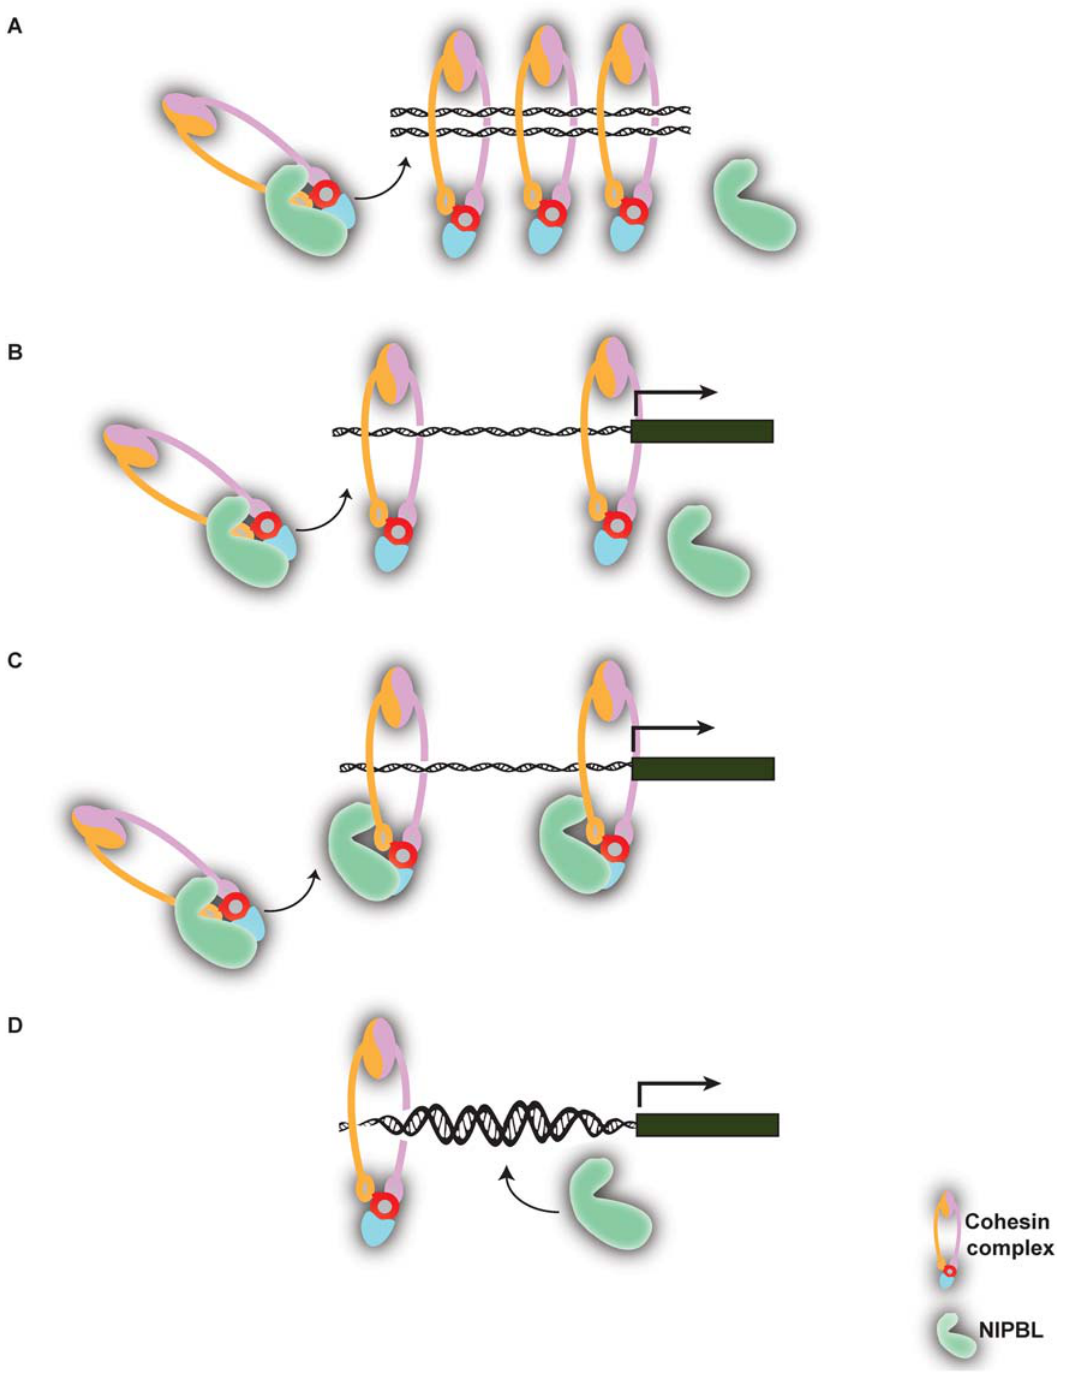
Figure 6. Proposed working models for cohesin and NIPBL. (A) Cohesin’s canonical role in regulating sister chromatid cohesion with NIPBL acting to facilitate the loading and unloading of the cohesin complex onto the chromosomes. It is not known if NIPBL directly interacts with chromatin. This model was described by Haering et al. [54]. (B) Cohesin loading model: NIPBL loads cohesin onto chromatin at the promoters or cis - regulatory elements after which cohesin regulates transcription without the direct involvement of NIPBL. (C) Cohesin and NIPBL collaborative model: Cohesin and NIPBL form a protein complex that binds to promoters or cis -regulatory elements. The functional integrity of this complex is required for transcriptional regulation of target genes. (D) NIPBL chromatin remodeling model: NIPBL may affect the accessibility for cohesin, e.g., by changing chromatin structures, to bind to chromatin elements through yet unknown pathways. Transcriptional regulation through cohesin is secondarily affected.